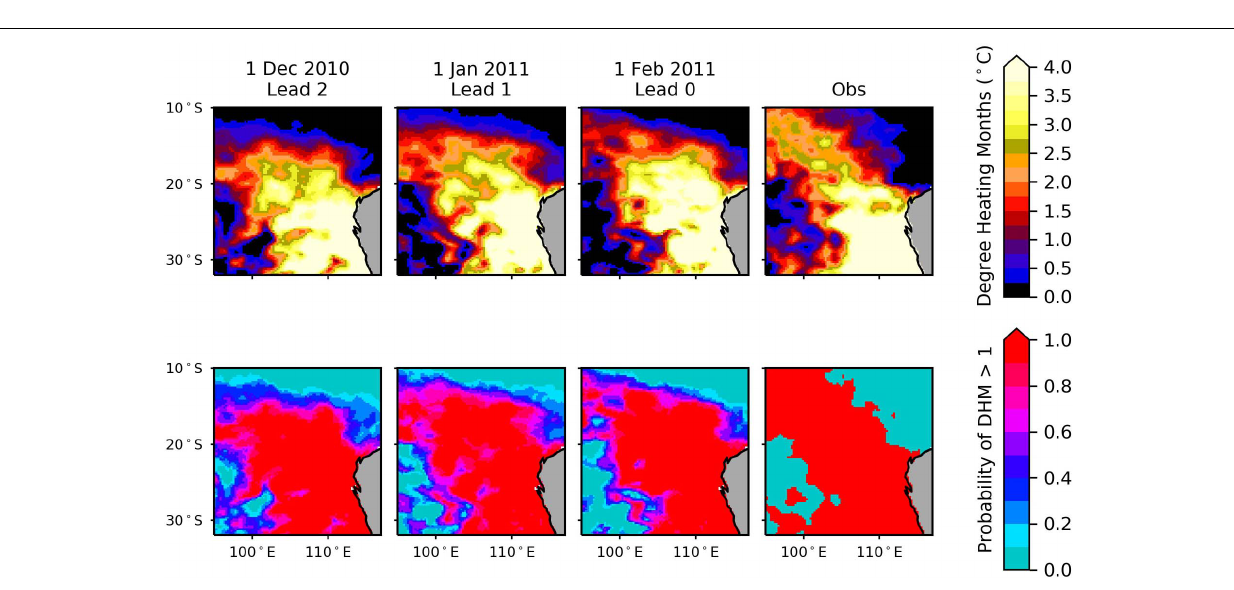
FIGURE 8 | Case Study 2: Hindcast DHM forecasts for Ningaloo for February to April 2011 for model start dates 1 December 2010, 1 January 2011, and 1 February 2011. Top row is ensemble mean DHM, bottom row is probability of DHM > 1, using 22 ensemble members. Observed DHM values for February to April 2011 are shown in the far-right